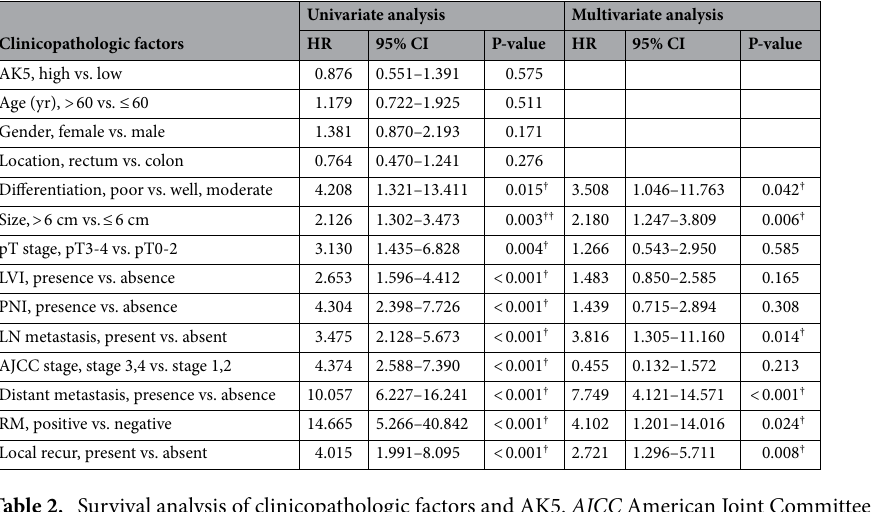
Table 2. Survival analysis of clinicopathologic factors and AK5. AJCC American Joint Committee on Cancer; LVI lymphovascular invasion, PNI perineural invasion, LN lymph node, RM resection margin, HR hazard ratio, CI confidence intervals. † P - values < 0.05 were considered statistically